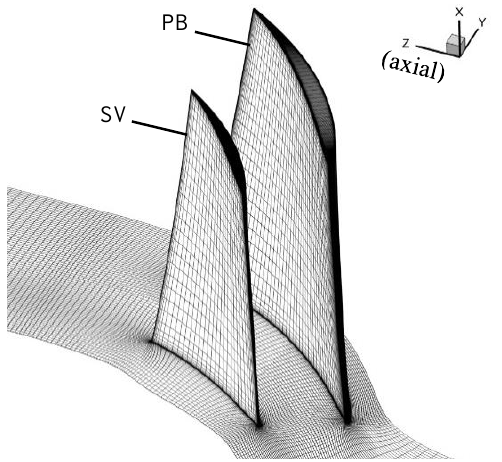
Figure 20. Grid for R2D with tip clearance.